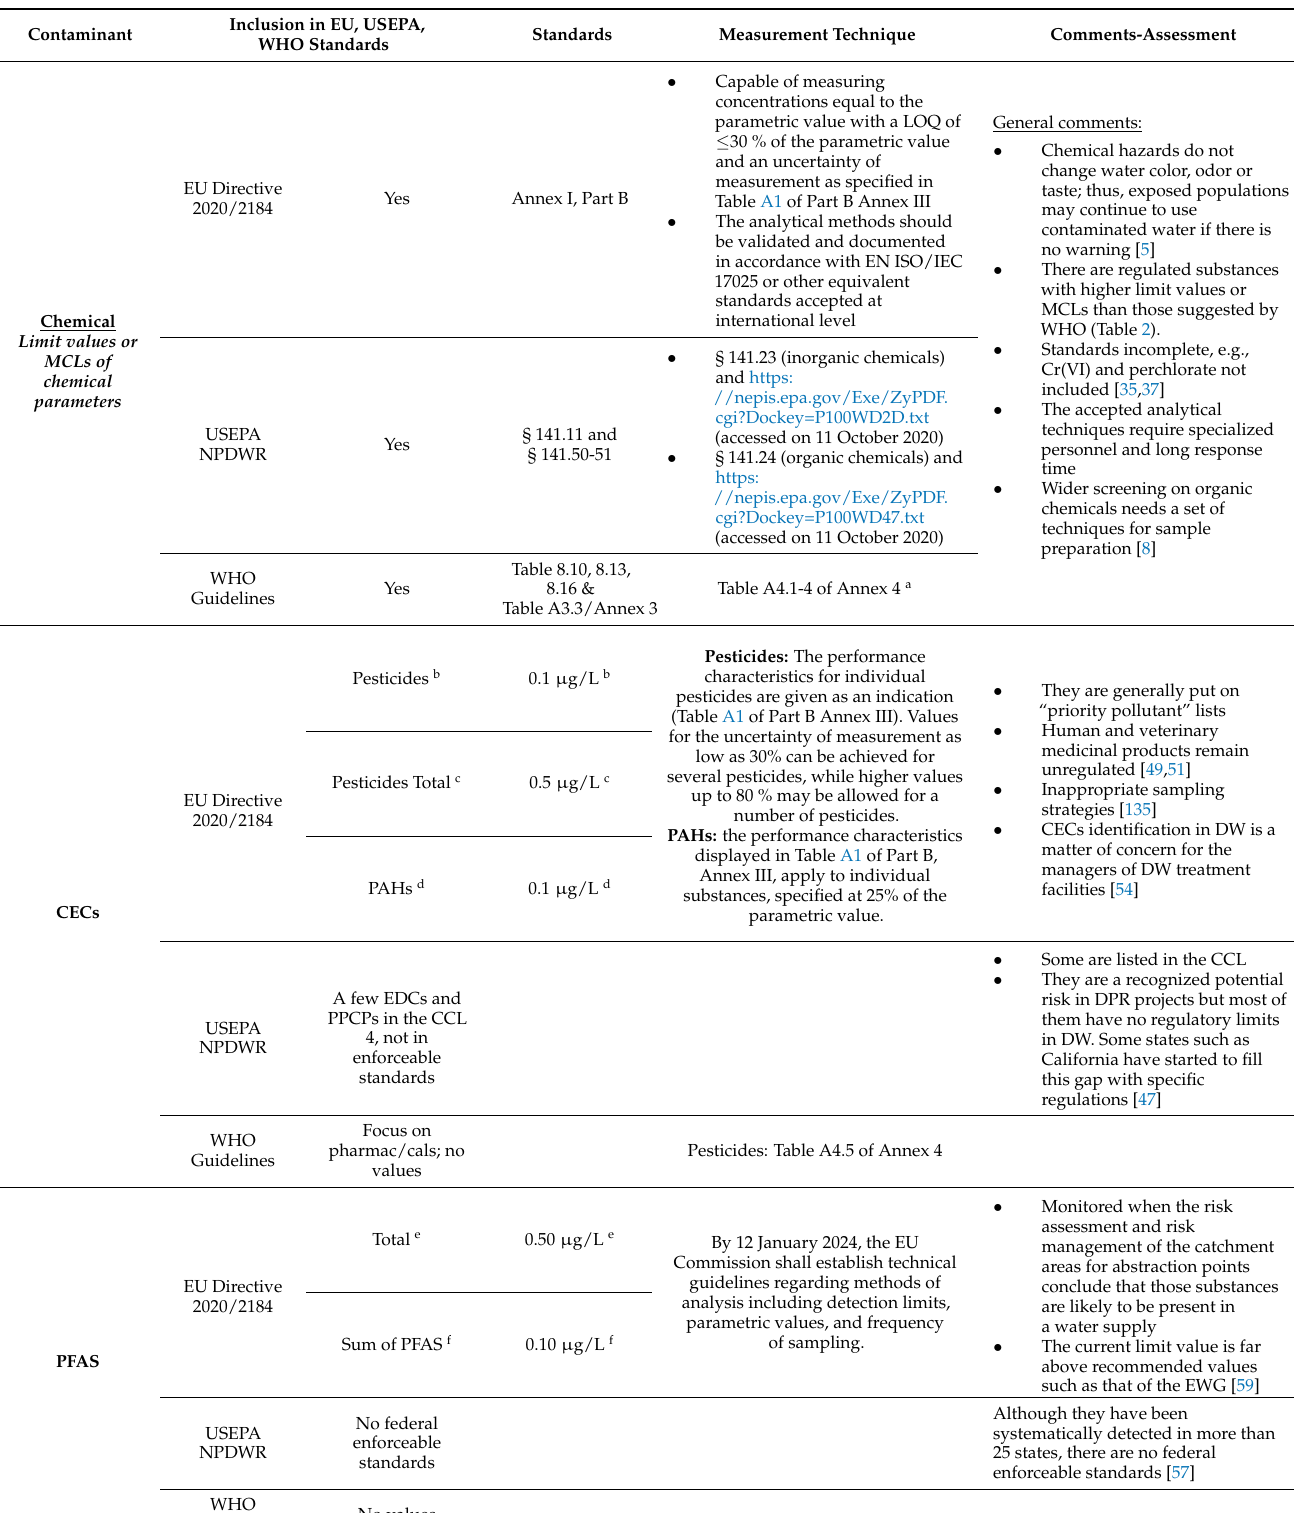
Pesticides: Table A4.5 of Annex